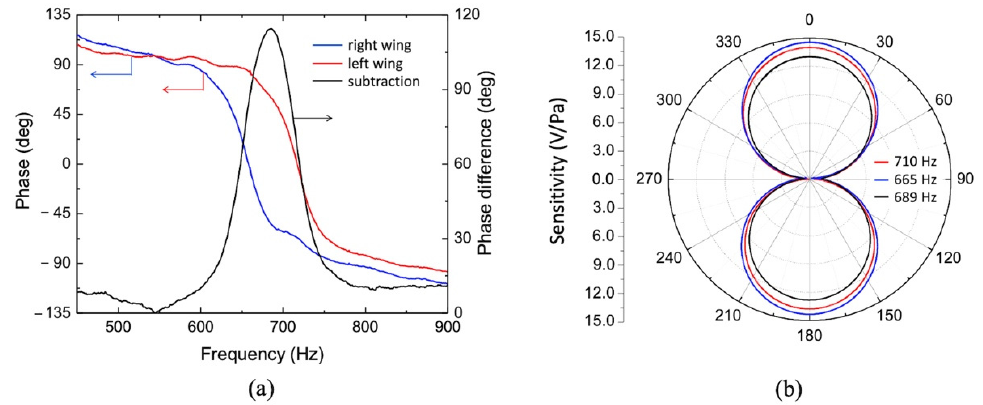
Figure 5. Phase and directionality characterization: ( a ) Measured phase frequency response for both wings separately (left side scale) and phase difference (right side scale). ( b ) Directional response measured at the peaks and valley between peaks of the subtraction of the two wing output signals, showing in Figure 4b, solid black line.